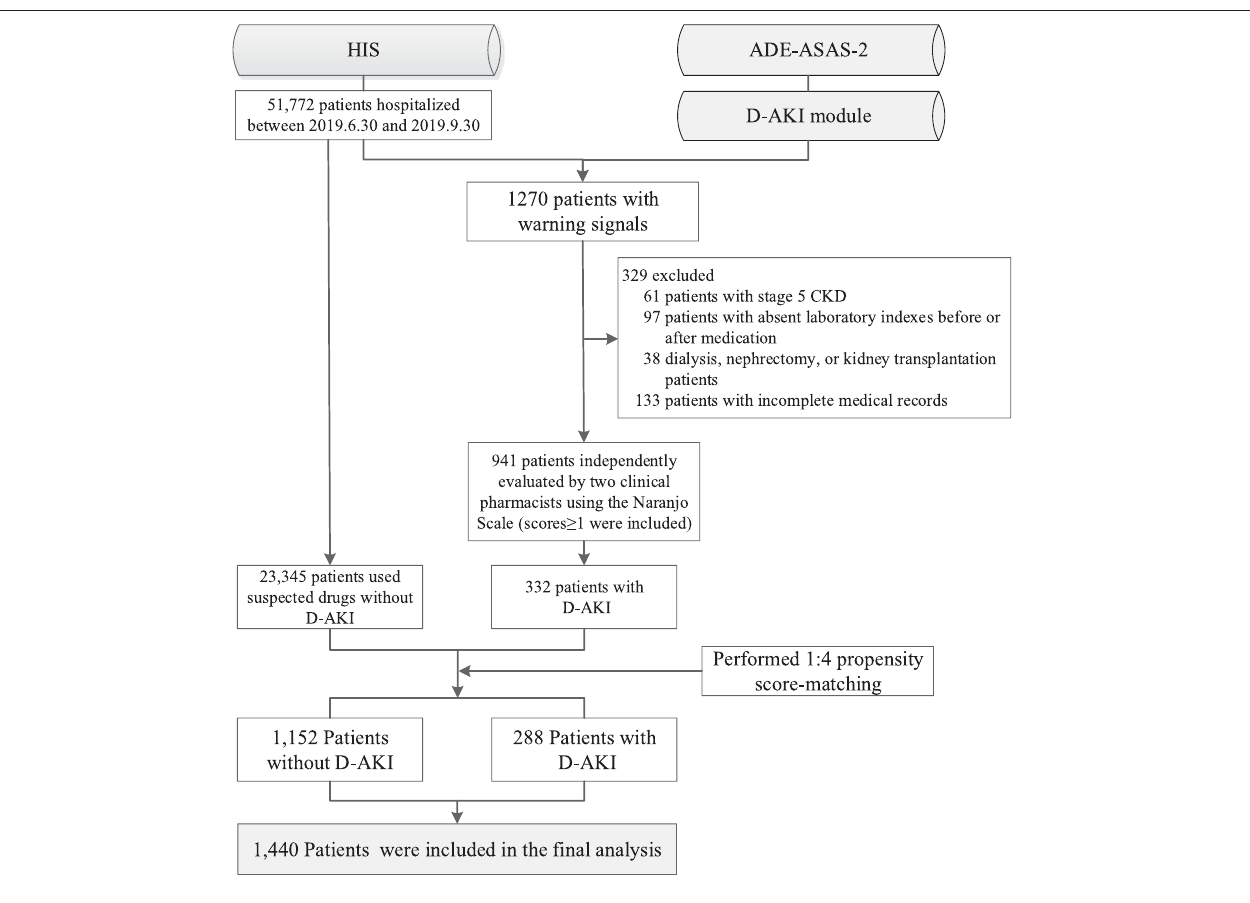
FIGURE 1 | Flow diagram of study population enrollment. HIS, hospital information system; ADE-ASAS-2, Adverse Drug Events Active Surveillance and Assessment System-2; D-AKI, drug-induced acute kidney injury; CKD, chronic kidney disease.